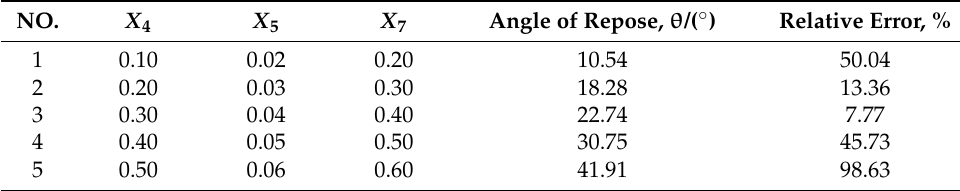
Table 7. Steepest ascent search test design scheme and